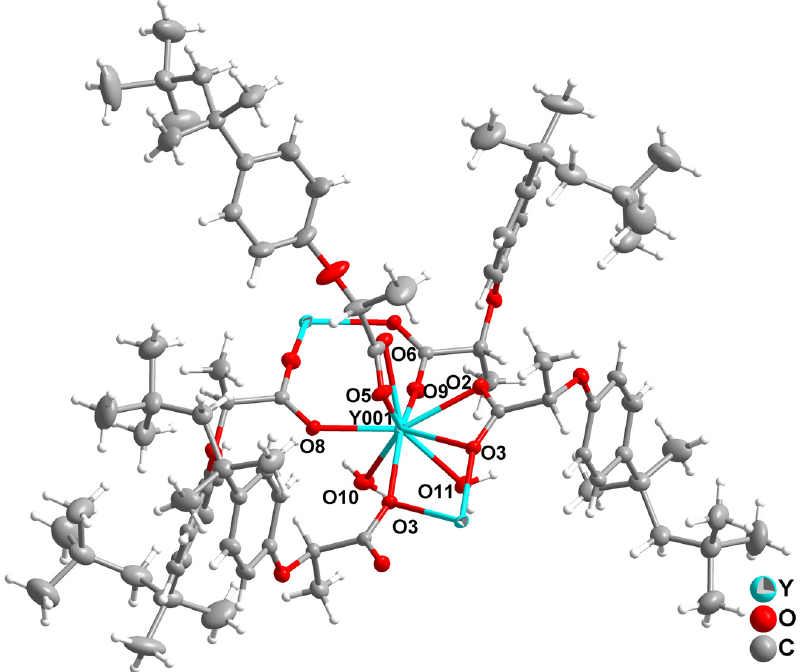
Table 1 contains crystallographic data and Table 2 contains the list of the atoms including atomic coordinates and displacement parameters.